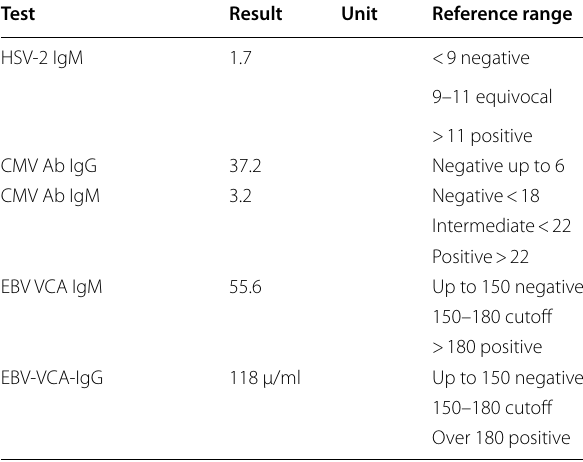
Table 1 Biochemical, immunologic, metabolic, and serological investigations